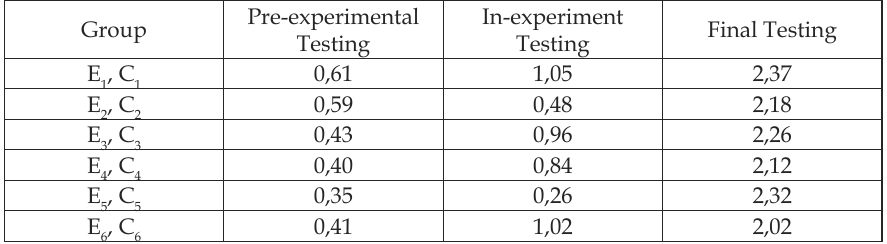
Table 3. In-experimental Wilcoxon, and Mann-Whitney U-tests values represent- ing estimation differences of each of the group pair (experimental and control ones) 2